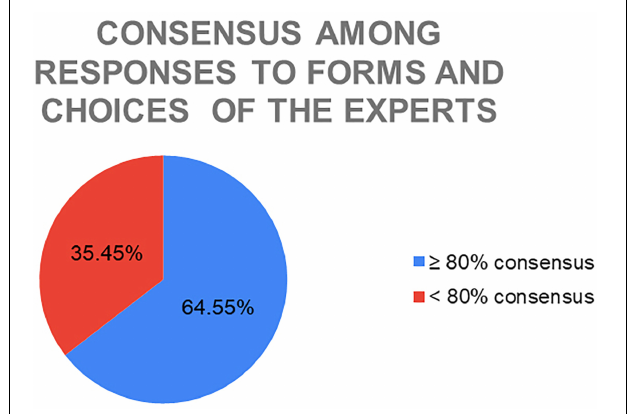
FIGURE 8 | Consensus among responses to form and choices of the experts.